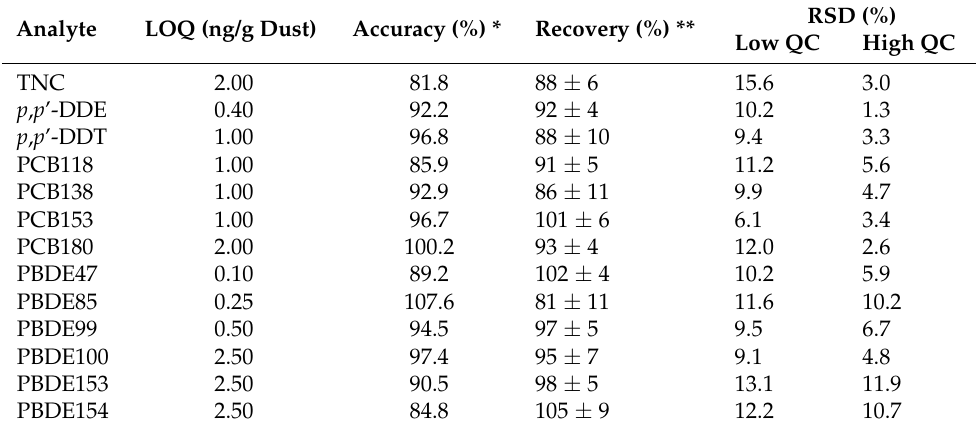
Table 2. Validation specifications of the method.